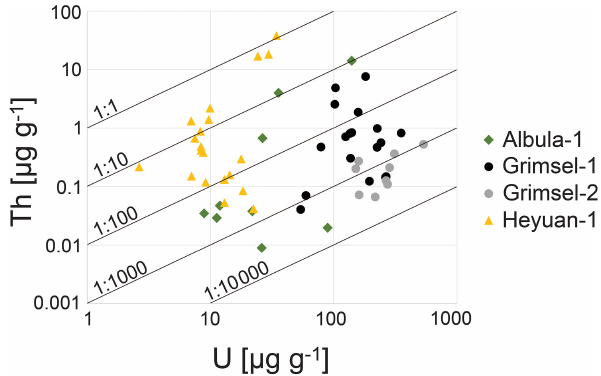
Figure 3. Th and U contents of the analyzed epidote